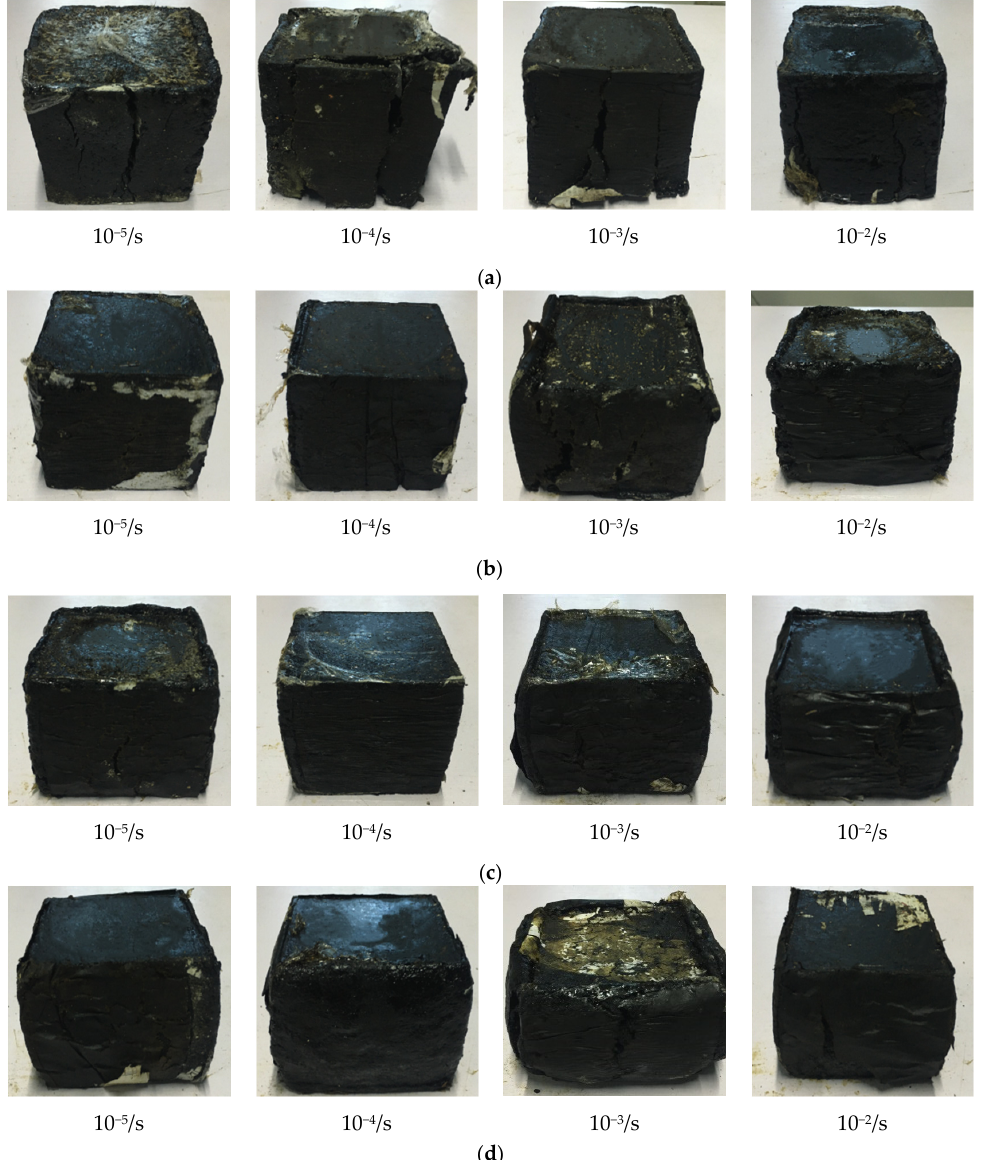
Figure 4. Failure modes of hydraulic asphalt concrete at various temperatures. ( a ) temperature − 20 °C; ( b ) temperature 0 °C; ( c ) temperature 25 °C; ( d ) temperature 45 °C.